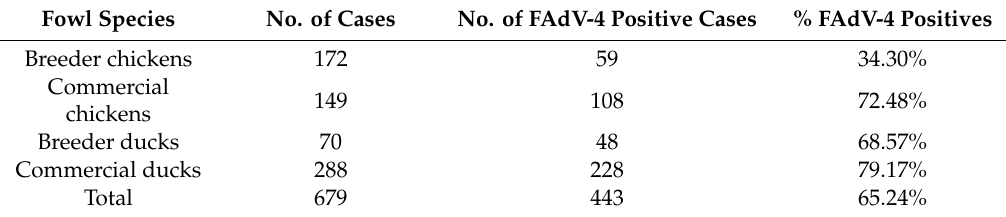
Table 2. FAdV-4 positive rates of clinical